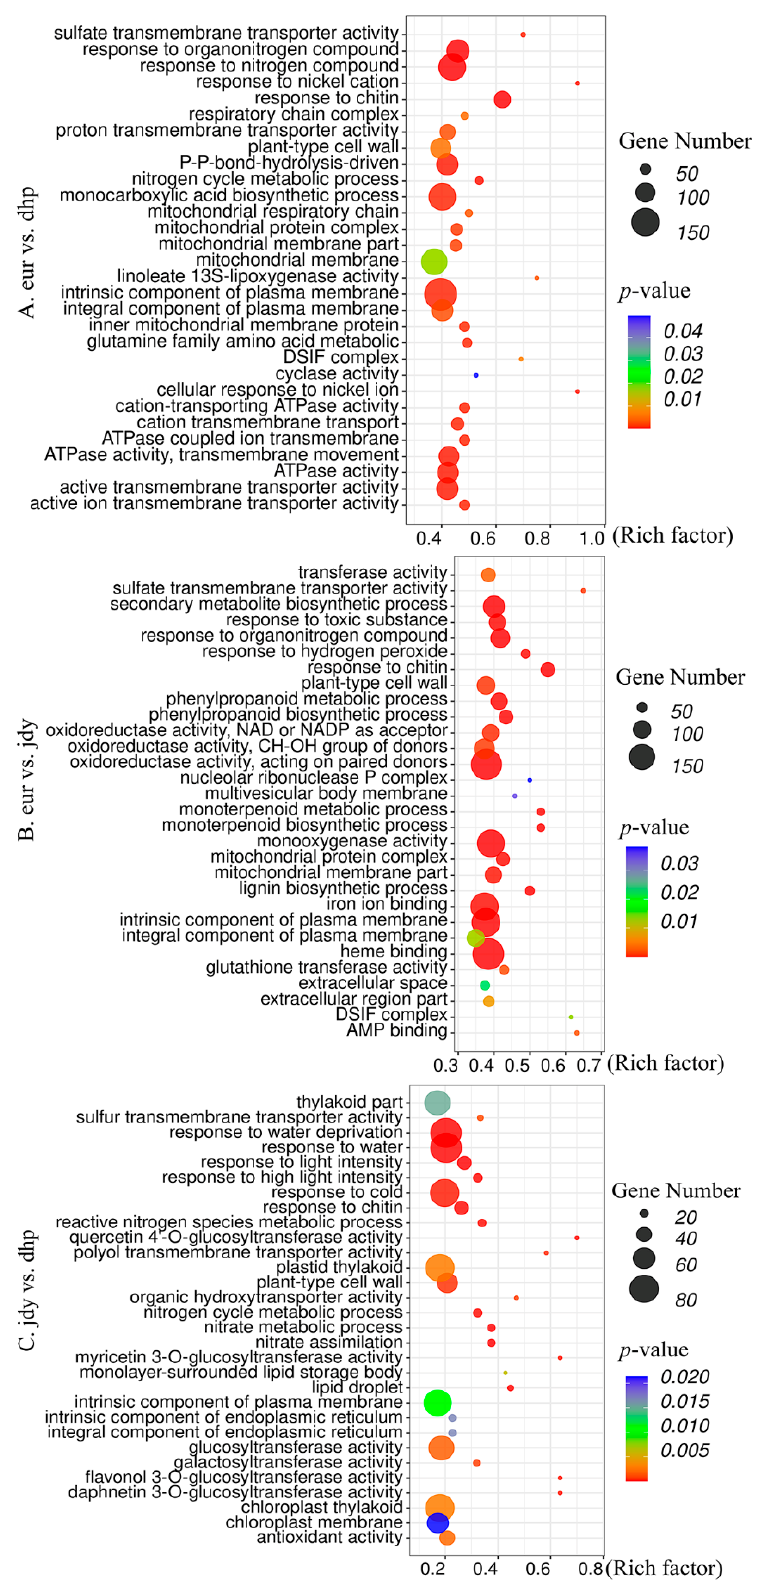
Figure 5. GO enrichment analysis of DEGs. Advanced bubble chart depicts enrichment of DEGs in different pathways. ( A ) “eur” vs. “dhp’; ( B ) “eur” vs. “jdy’; ( C ) “jdy” vs. “dhp”. Sum denotes the number of DEGs and rich factors are considered to be the ratio of DEGs in each GO analysis compared with total number of DEGs.